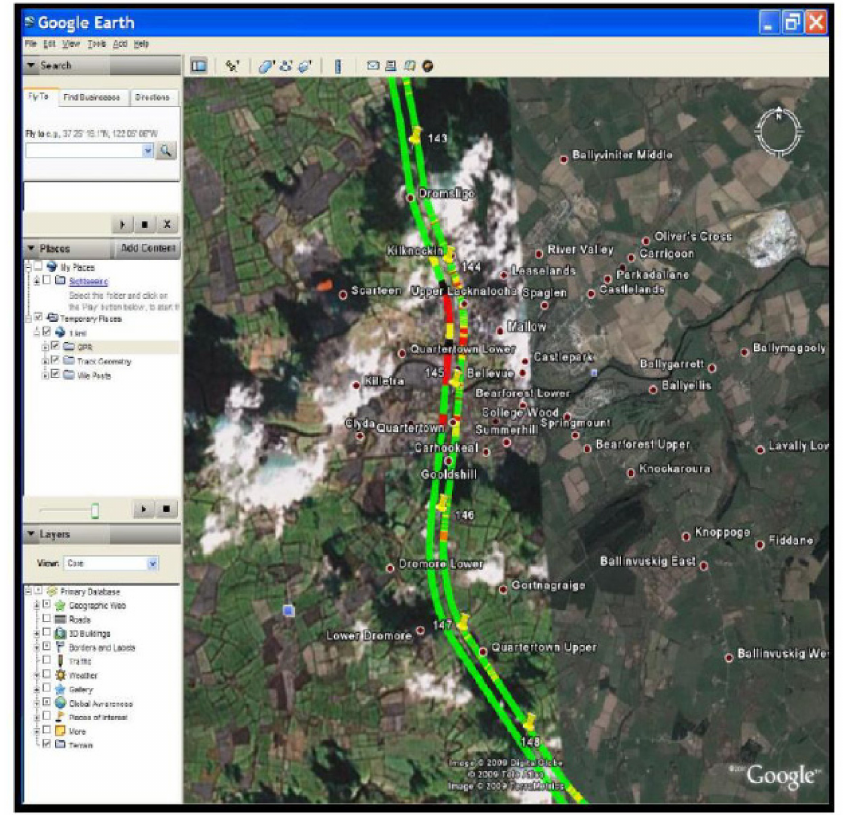
Figure 20. CTQI and Google Earth integration demonstration (figure reproduced from